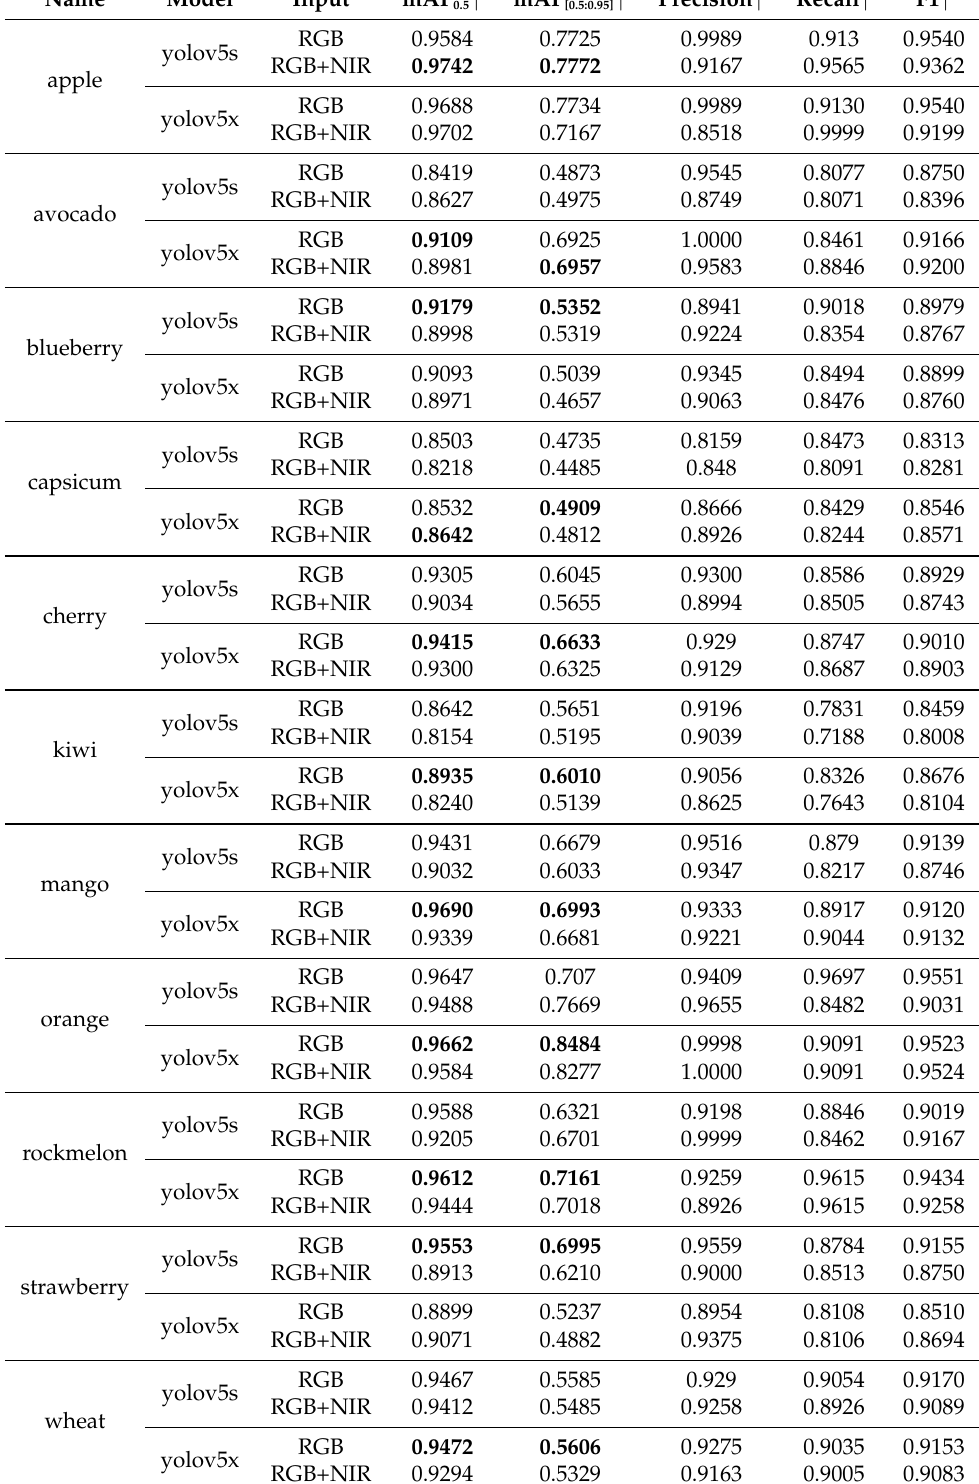
Table 6. Eleven fruits/crops object detection quantitative results table. Up-arrow indicates a higher score is better performance. Bold denotes the best performance in the corresponding metric within each